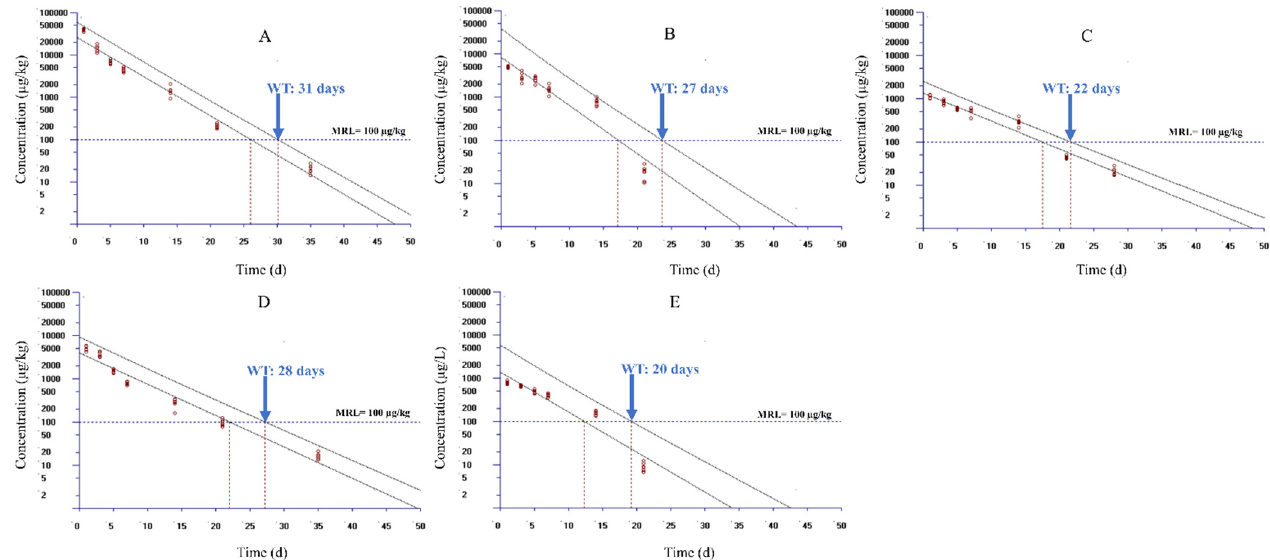
Figure 2. Calculated withdrawal times of doxycycline in yellow catfish ( Pelteobagrus fulvidraco ) following continuous 3-day oral gavage at 20 mg/kg/day based on the MRL standard in Europe and China using the WT 1.4 software. Panels ( A – E ) show the results for liver, kidney, muscle + skin, gill, and plasma, respectively. MRL, maximum residue limit for doxycycline from the European Medicines Agency and the Ministry of Agriculture and Rural Affairs of the People’s Republic of China.